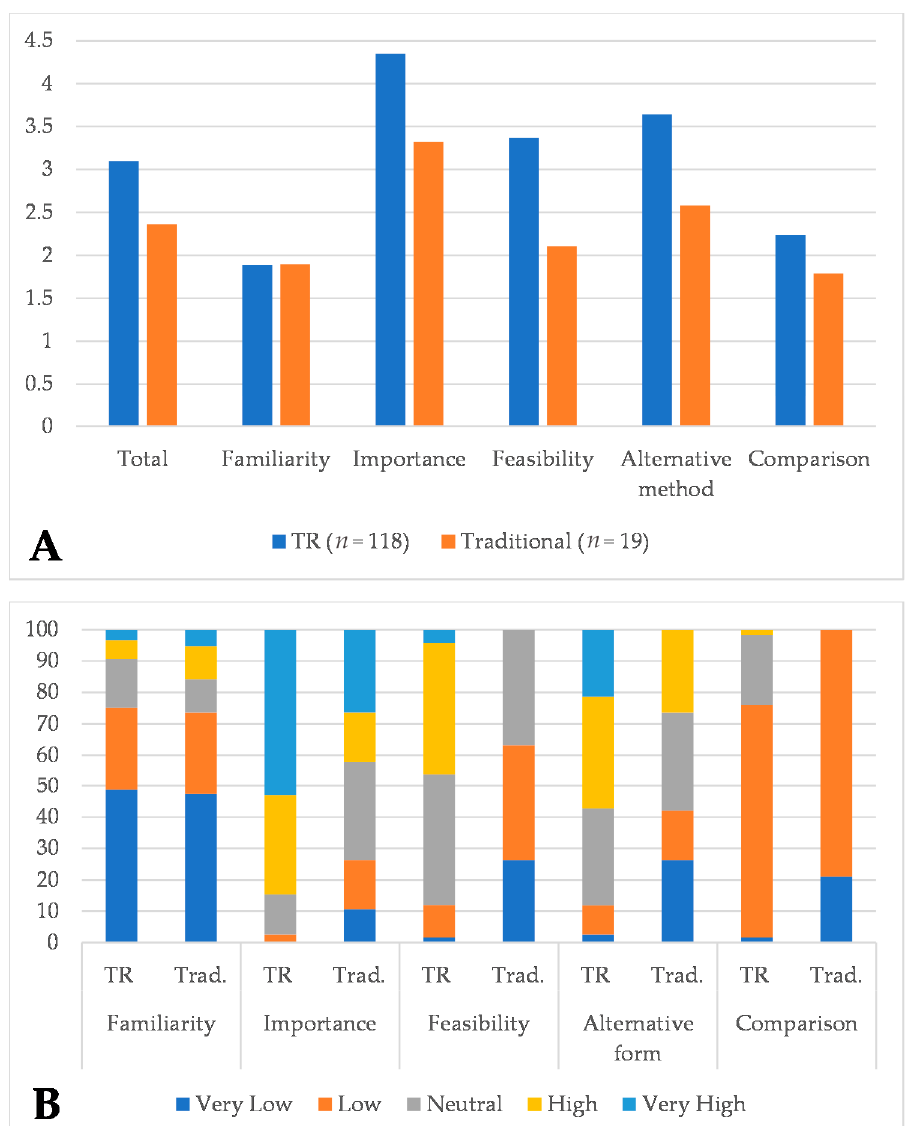
Figure 1. Domains comparison between telerehabilitation (TR) and traditional therapy in mean differences ( A ) and percentages results ( B ).